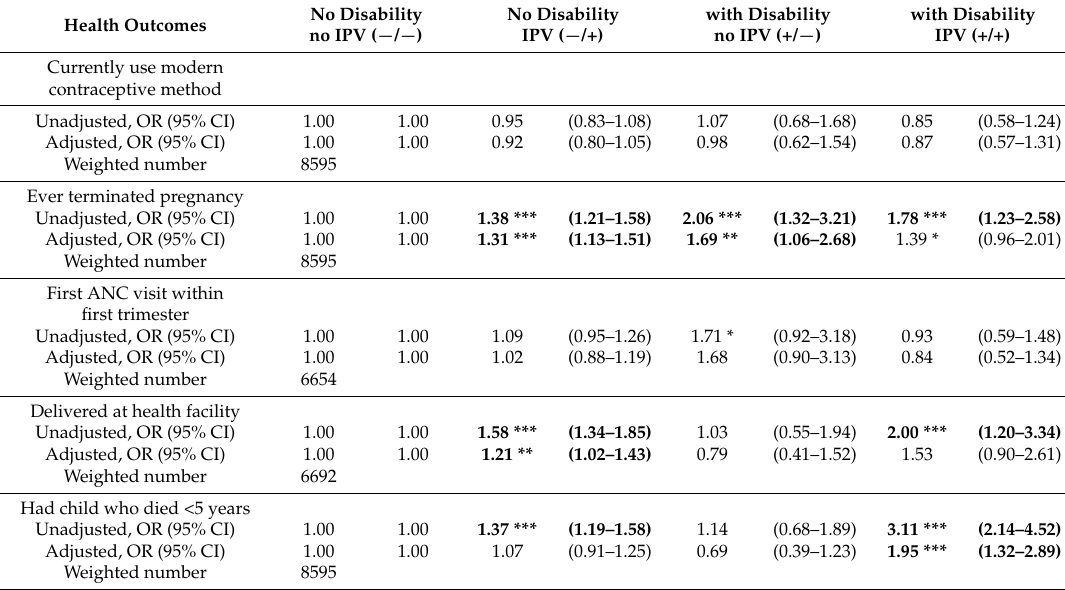
Table 3. Odds ratios (OR) of select health outcomes among women with and without disabilities by experience of intimate partner violence, aged 15–49, Uganda: unadjusted and adjusted odds ratios. No Disability No Disability with Disability with Disability Health Outcomes no IPV ( − / − ) IPV ( − /+) no IPV (+/ − ) IPV